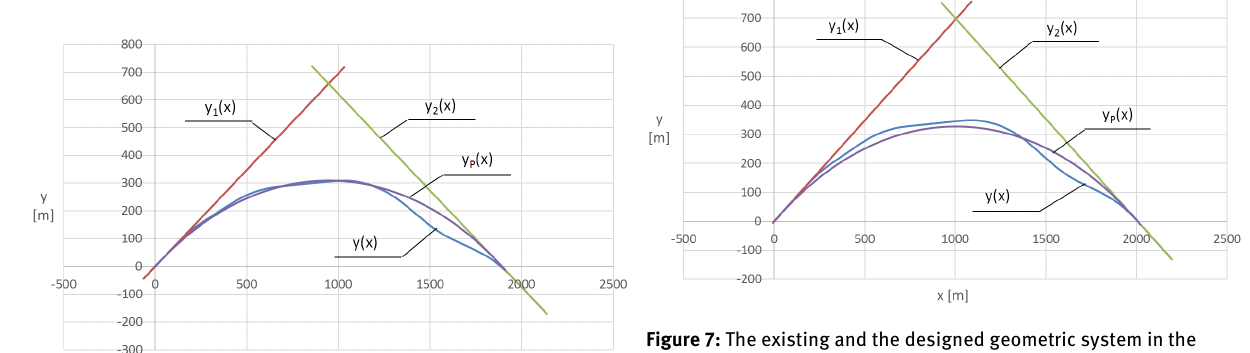
Figure 7: The existing and the designed geometric system in the local system of coordinates (variant III, using the non-isometric scales); y ( x ) – the existing course of the route, y 1 ( x ) and y 2 ( x ) – determined main directions of the route, y P ( x ) – designed course of the